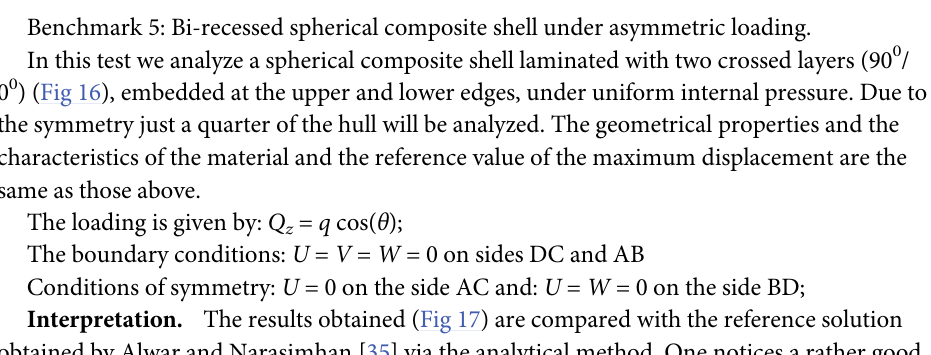
Benchmark 5: Bi-recessed spherical composite shell under asymmetric loading.